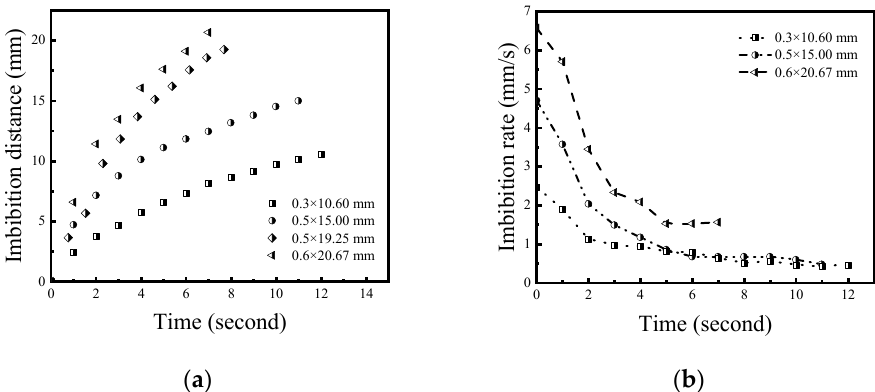
Figure 5. ( a ) Diagram of the imbibition distance as a function of time in water-displacing-oil experiments in circular single channels. ( b ) Diagram of the imbibition rate as a function of time. (Three of the four sets of experiment data specified in ( a ) are selected randomly for the subsequent fitting analysis, and the remaining one set of data thereof is for verification on fitting steps, as indicated in ( b )).